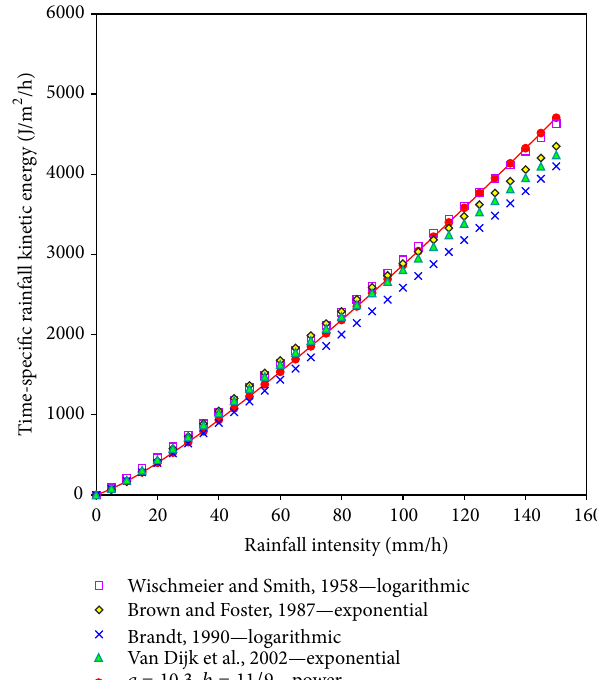
Figure 4: Comparison of time-specific kinetic energies between empirical equations presented in South Korea and universal power